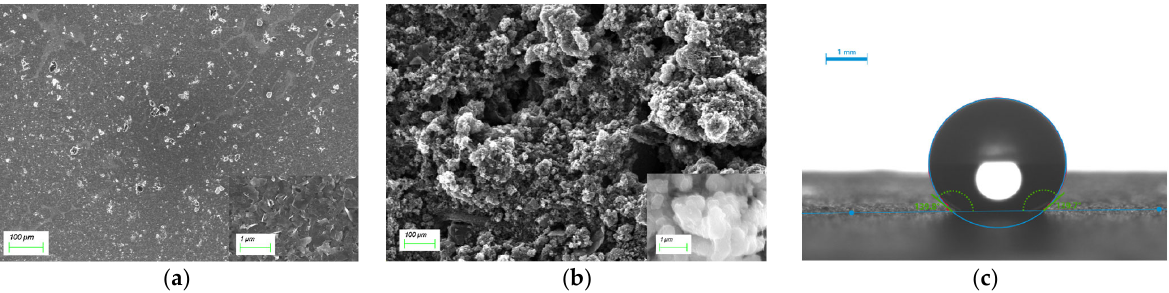
Figure 1. ( a ) Image of CB − ISM solid contact layer, illustration: 1 µm enlarged image; ( b ) image of POT − CB − ISM solid contact layer, illustration: 1 µm enlarged image; ( c ) POT − CB − ISM static contact angle image.